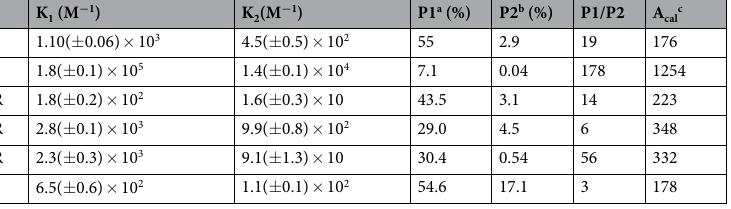
Table 2. The binding constants between [Zn 3 -BTATPP] and mono-alcohols and calculated CD contributions per unit. a P1, percentage of 1:1 complex at the corresponding low concentration C in Table 1; b P2, percentage of 1:2 complex; c A cal , calculated values by A obs /P1, A obs is the value in Table